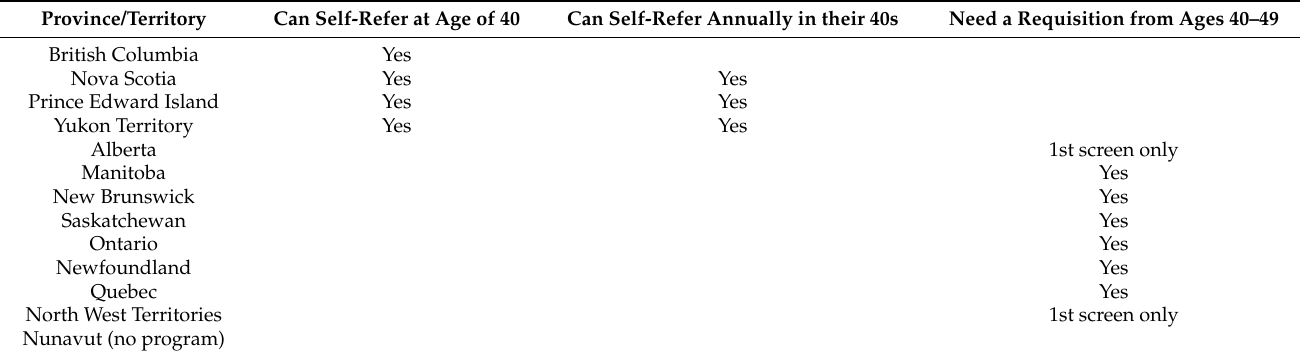
Table 3. Screening differences between jurisdictions in Canada for women aged 40–49 [36].